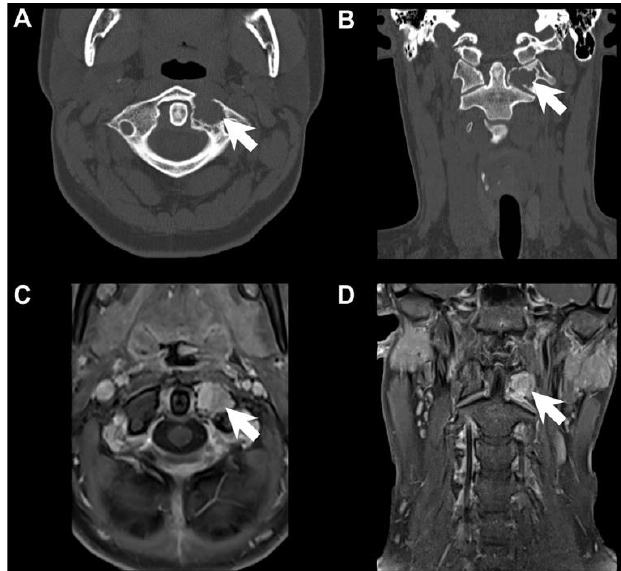
Figure 1. Pre-Operative Imaging Studies. CT of cervical spine, axial view, demonstrating the radiolucent, ovoid-shaped, lytic lesion (white arrow) arising in the left lateral mass of C1 between the anterior tubercle and the transverse process ( A ). CT of cervical spine, coronal view, demonstrating the lesion (white arrow) ( B ). Post-contrast MRI T1, axial view, demonstrating an enhancing osseous lesion (white arrow) at the left lateral mass of C1 with cortical breach and extension into the left lateral atlantodental joint space ( C ). Post-contrast MRI T1, coronal view, of the lesion (white arrow) ( D ).